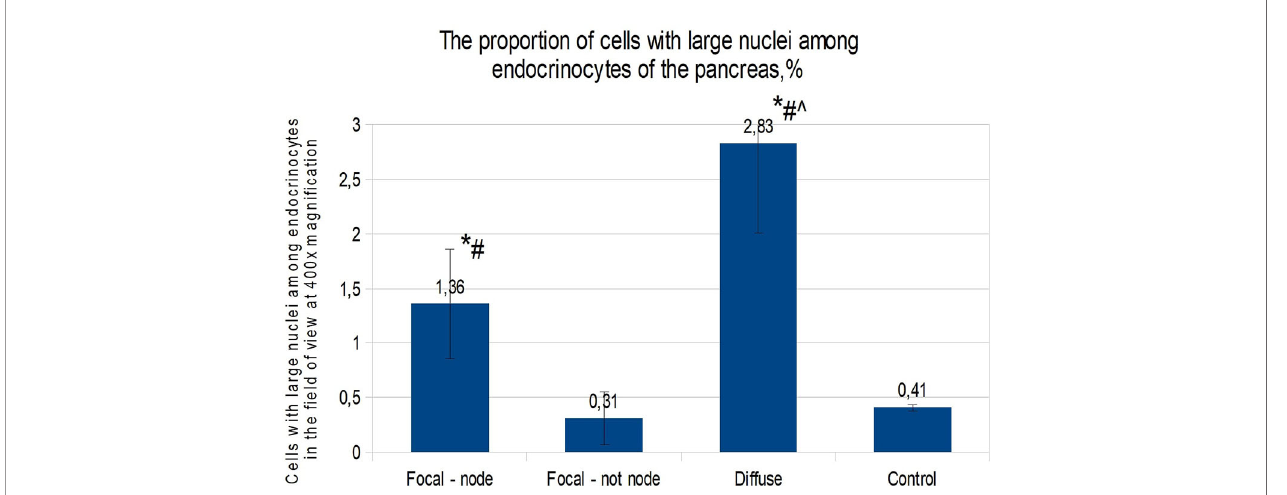
FIGURE 4 | The proportion of cells with enlarged nuclei among endocrinocytes in the fi eld of view (percentage), frozen sections. Data are presented as M ± SD. (*) - the difference in comparison with the control is statistically signi fi cant at p <0.05; (#) - the difference in comparison with tissue of the pancreas outside the lesion in the focal form is statistically signi fi cant at p <0.01; (^) - the difference compared with the zone of adenomatous hyperplasia is statistically signi fi cant at p <0.01. Note: focal node- zone of adenomatoushyperplasia infocal form; focalnot node- pancreatictissue outside the zone of adenomatoushyperplasia; diffuse - diffuse form.